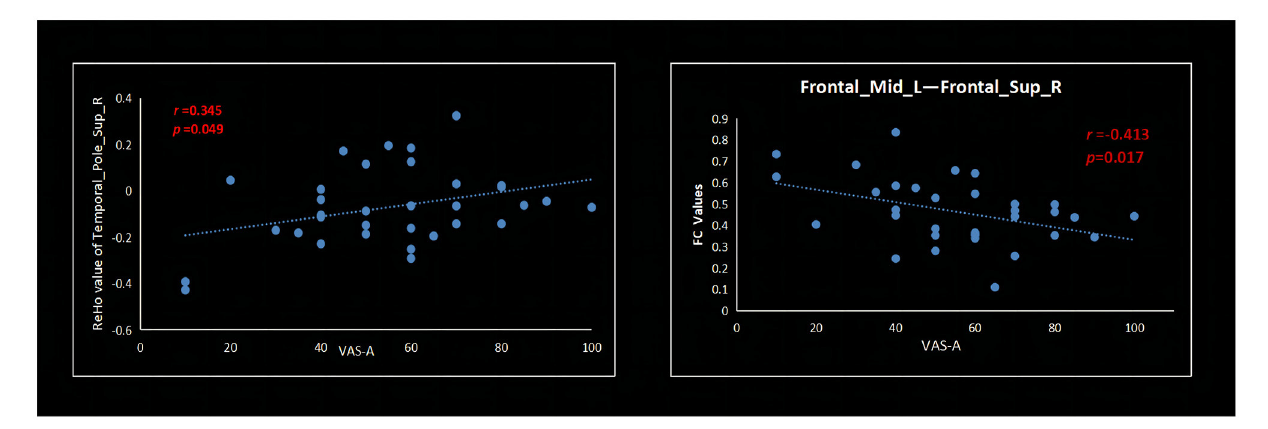
FIGURE4 Analysis through Pearson’s correlation: VAS-A is positively correlated with increased ReHo values of the right temporal pole superior temporal gyrus and negatively correlated with FC values between the left middle frontal gyrus and the right superior frontal gyrus. VAS-A, visual analog scale for anxiety.